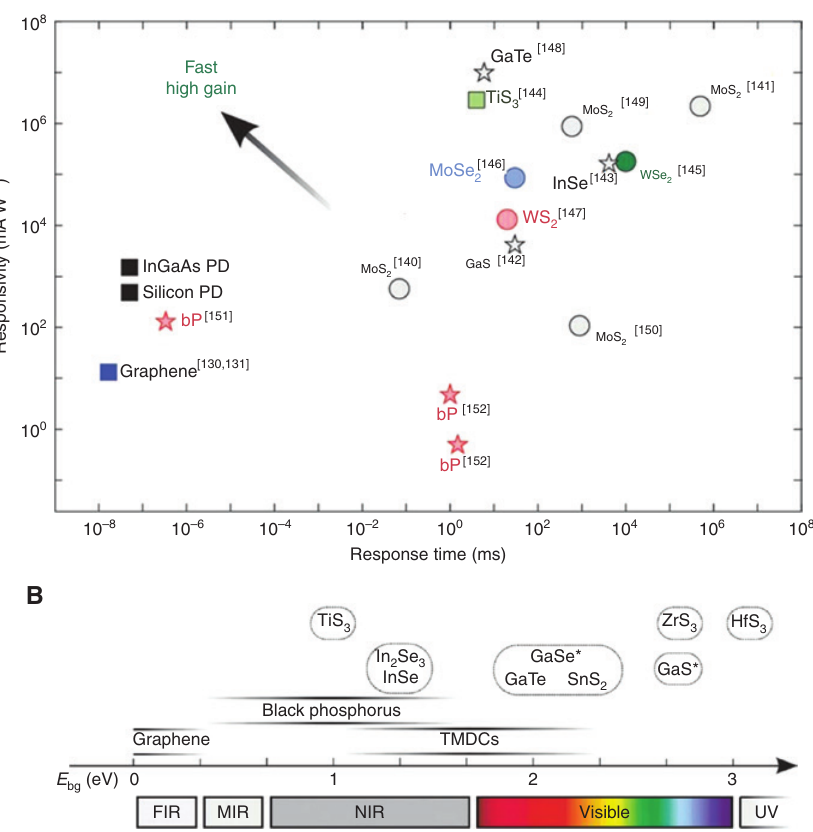
Figure 8: Summarization of important characteristics for detection application using different 2D materials. (A) Responsivity versus the response time for detectors based on 2D material, and comparison with commercial silicon and InGaAs photodi- odes (black squares). (B) Bandgap of the different layered semiconductors and the covered electromagnetic spectrum. The exact bandgap value would depend on the number of layers, strain level and chemical doping. The asterisk indicates that the material’s fundamental bandgap is indirect